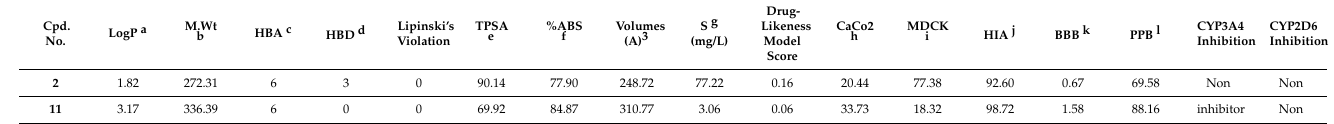
Table 6. In silico physicochemical properties, drug-likeness and ADME data of the most active